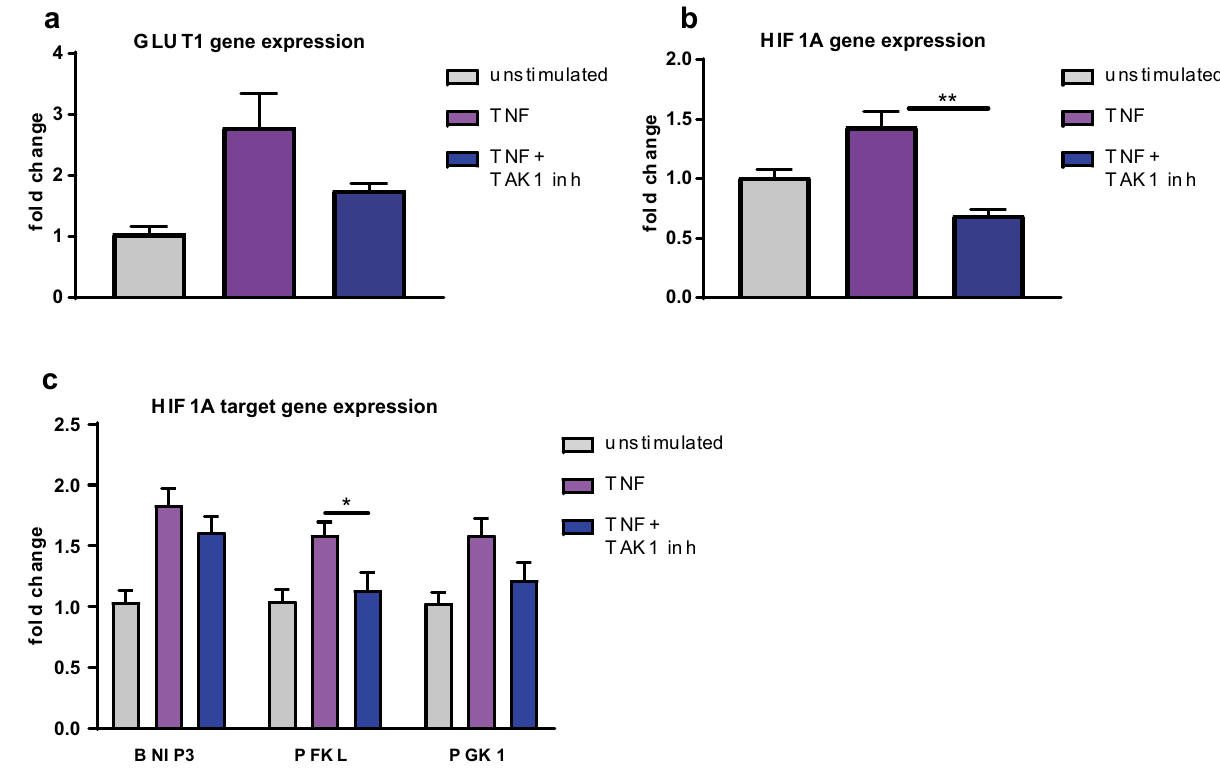
Figure 4. TNF induces upregulation of GLUT1 and HIF1A via TAK1. ( a – c ) Fibroblast-like synoviocytes from three healthy donors were stimulated with recombinant human TNF (2 ng/mL) and the TAK1 inhibitor (5Z)-7-oxozeaenol (0.5 µM) for 24 h and expression of GLUT1 ( a ), HIF1A ( b ) and HIF1A target genes ( c ) was evaluated (n ≥ 3, 3 different donors). Values represent means ± SEM. *P ≤ 0.05; **P ˂ 0.01. Unpaired one-way Anova with Dunnett